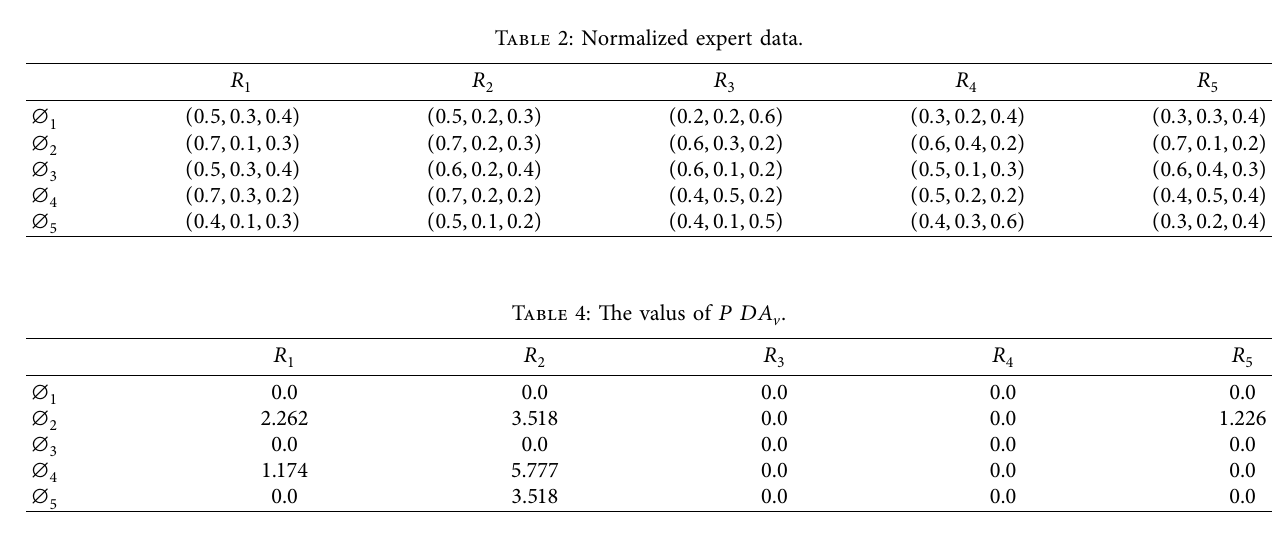
Table 3: Score value of Z